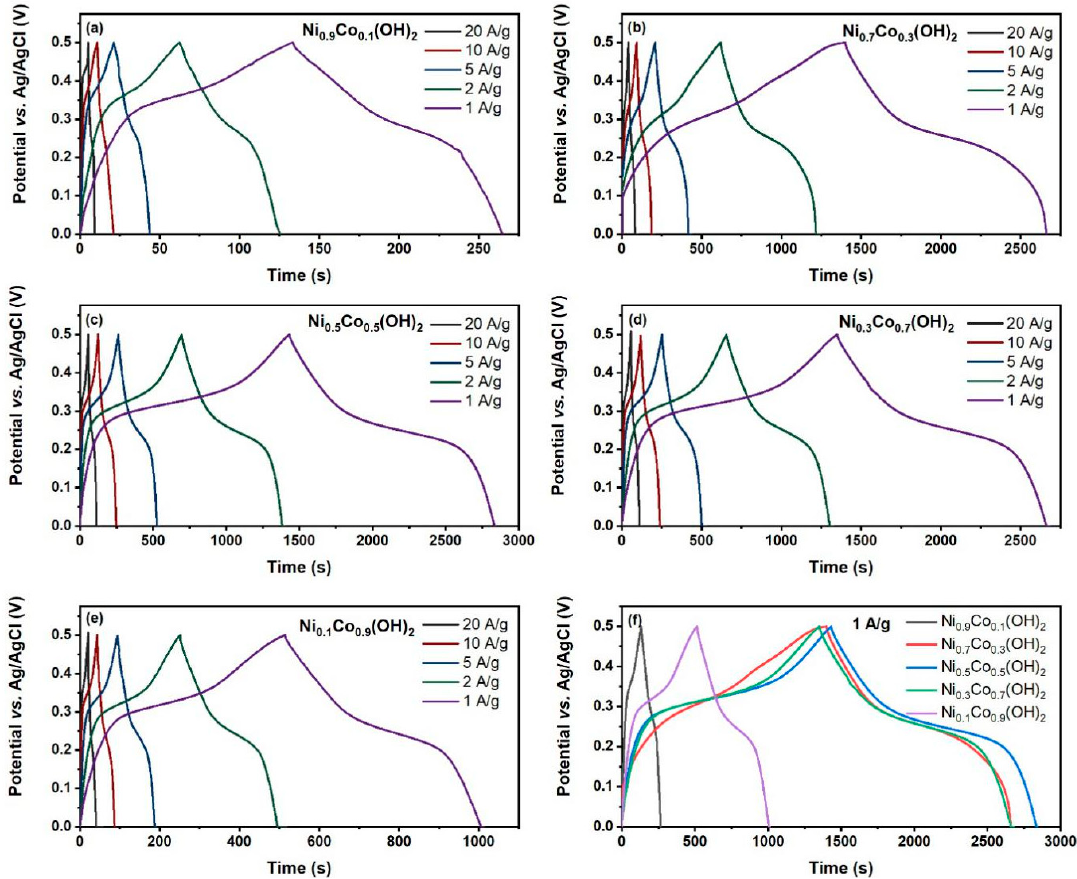
Figure 5. Galvanostatic charge/discharge (GCD) curves at current densities from 1 to 20 A/g: ( a ) Ni 0.9 Co 0.1 (OH) 2 ; ( b ) Ni 0.7 Co 0.3 (OH) 2 ; ( c ) Ni 0.5 Co 0.5 (OH) 2 ; ( d ) Ni 0.3 Co 0.7 (OH) 2 ; ( e ) Ni 0.1 Co 0.9 (OH) 2 ; ( f ) GCD curves of the Ni 1-x Co x (OH) 2 electrodes at current density of 1 A/g. The specific capacitances based on the GCD tests were determined according to Equation (1).